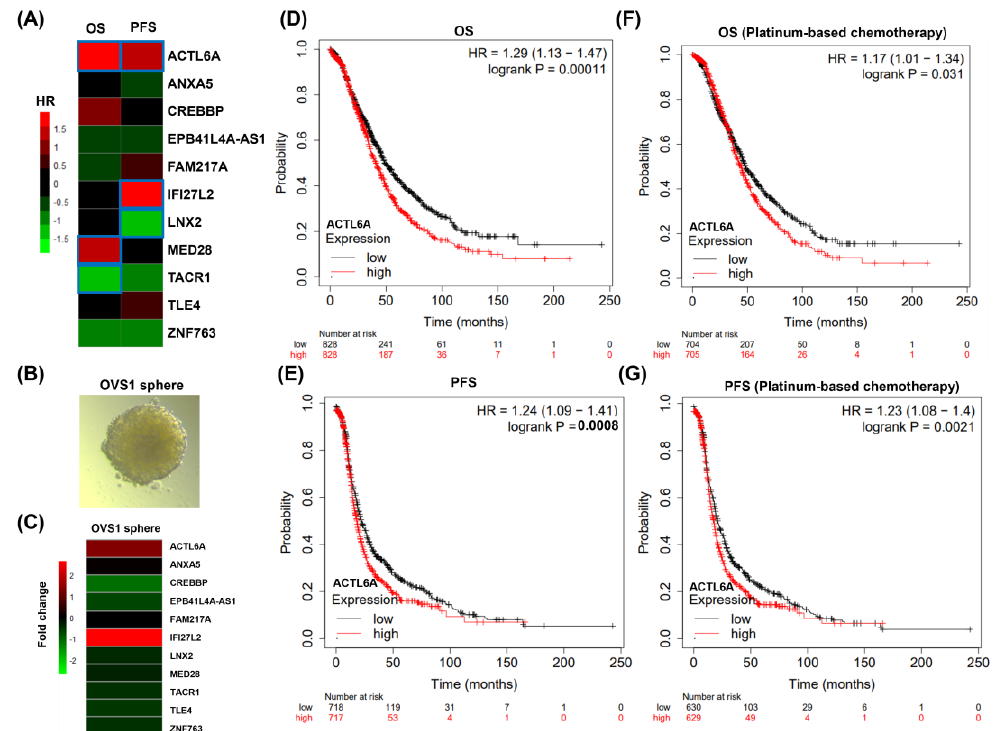
Figure 2. GACTL6A has poor prognosis for overall survival (OS) and progression-free survival (PFS) ( A ) Heat map of hazard ratios (HR) illustrating cancer-11 DEGs with altered prognosis. We selected the median as the suitable expression threshold for splitting the high-expression and low-expression cohorts. The hazards ratio (HR) was calculated based on the Kaplan–Meier survival method, and the HR value was scaled in decibel. ( B ) Formation of spheres under the stem cell selective condition on day 8 after culturing from parental OVS1. ( C ) Changes in gene expression of CREBBP, ACTL6A, ANXA5, EPB41L4A-AS1, FAM217A, IFI27L2, LNX2, MED28, TACR1, TLE4, and ZNF763 in a heat map. ( D ) All ovarian cancer patients revealed that patients with high expression of ACTL6A had worse overall survival (OS) compared to the ACTL6A low expression patients. ( E ) All ovarian cancer patients revealed that patients with high expression of ACTL6A had worse progression-free survival (PFS) compared to the ACTL6A low expression patients. ( F ) Chemotherapy ovarian cancer patients revealed that patients with high expression of ACTL6A had worse overall survival (OS) compared to the ACTL6A low expression patients. ( G ) Chemotherapy ovarian cancer patients revealed that patients with high expression of ACTL6A had worse progression-free survival (PFS) compared to the ACTL6A low expression